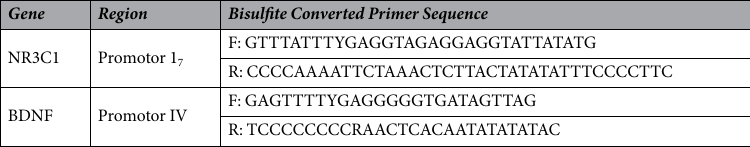
Table 1. Primer sequences for methylation